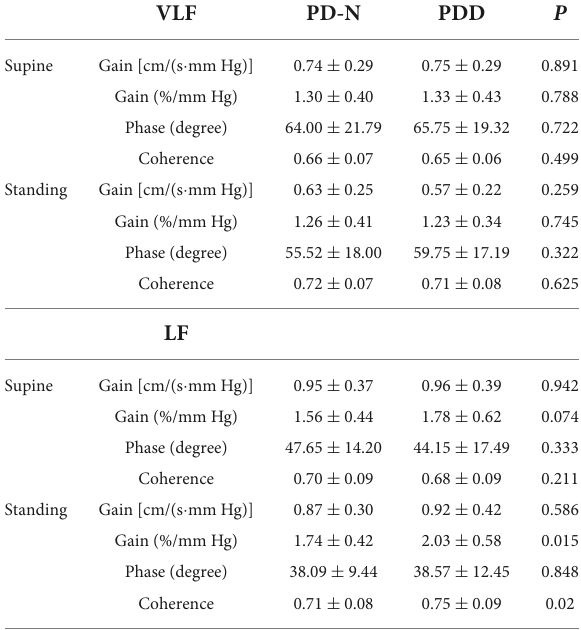
TABLE 5 Comparison of cerebral autoregulation parameters in the PD patients with and without dementia. VLF PD-N